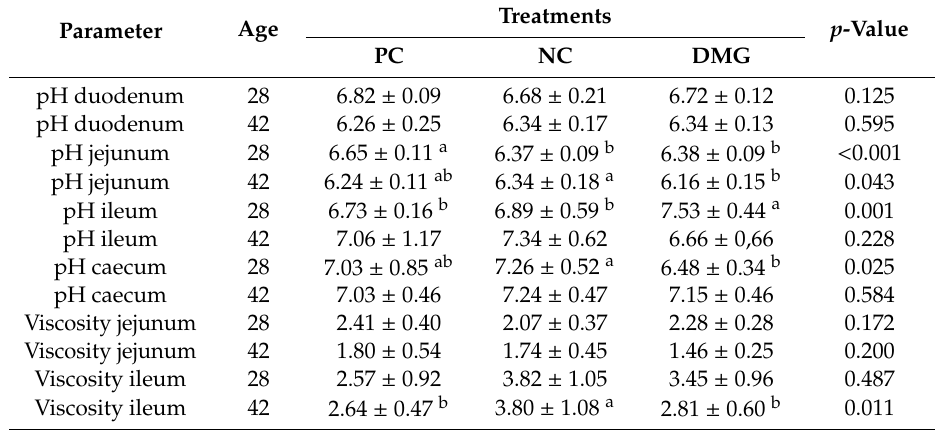
Table 5. Average values of pH and viscosity at di ff erent parts of the intestine, measured at 28 and 42 days of